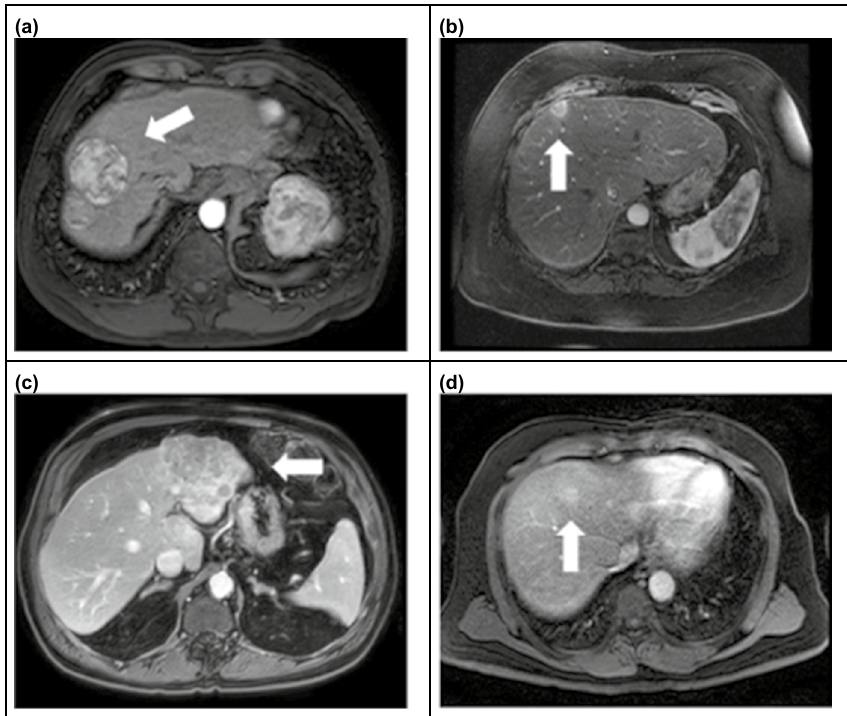
Fig. 1 Example HCC lesions as seen on dynamic post-contrast T1-weighted fat-saturated MRI images. a Large, well defined (code 46.1, corresponding to patient #46, lesion #1). b Small, well defined (39.3). c Large, poorly defined (49.1). d Small, poorly defined (55.4). Each image is displayed in the optimum visualization window and phase used for